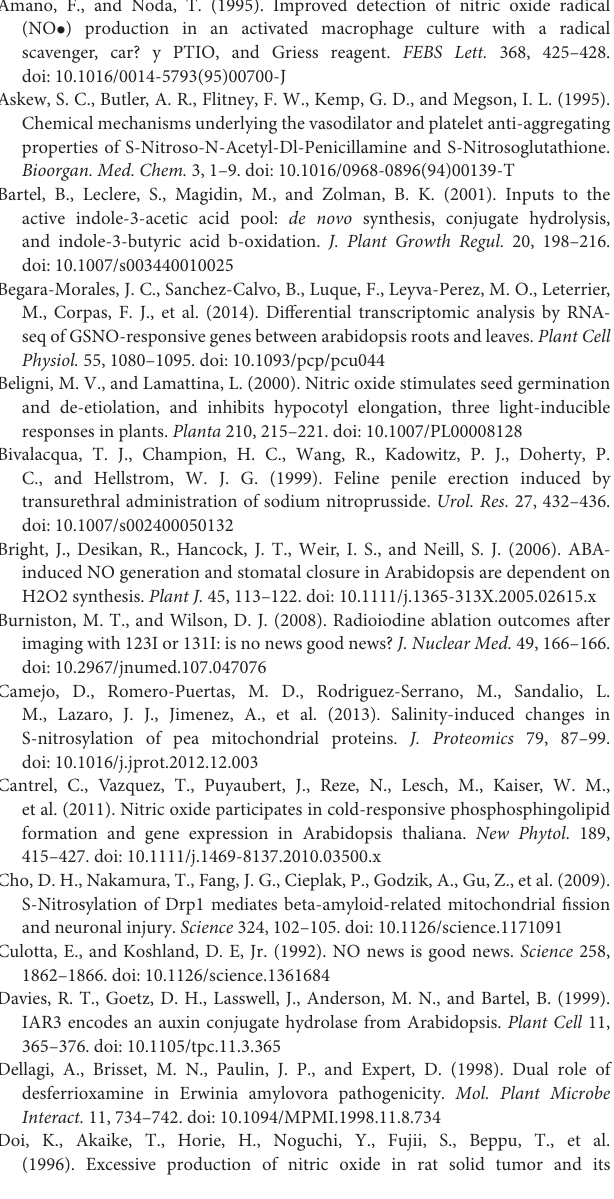
Supplementary Figure 3 | Cotyledon development frequency (CDF), after treatment with oxidative (H 2 O 2 and MV), and nitrosative (CySNO and GSNO) stress conditions in atill6 mutant line and relevant control plants. All data points show the mean of at least three replicates, and the experiment was repeated twice with similar results. The significant difference between the treatments is represented by (a, b, c, d) one-way ANOVA analysis of varience, followed by Duncan’s multiple range test using statistical analysis system (SAS 9.1). Supplementary Figure 4 | Phenotypic responses, after treatment with oxidative (H 2 O 2 and MV), and nitrosative (CySNO and GSNO) stress conditions in atill6 mutant line and relevant control plants. Supplementary Figure 5 | Symptom development in atill6 and relevant control after inoculation with Pst DC3000 virulent